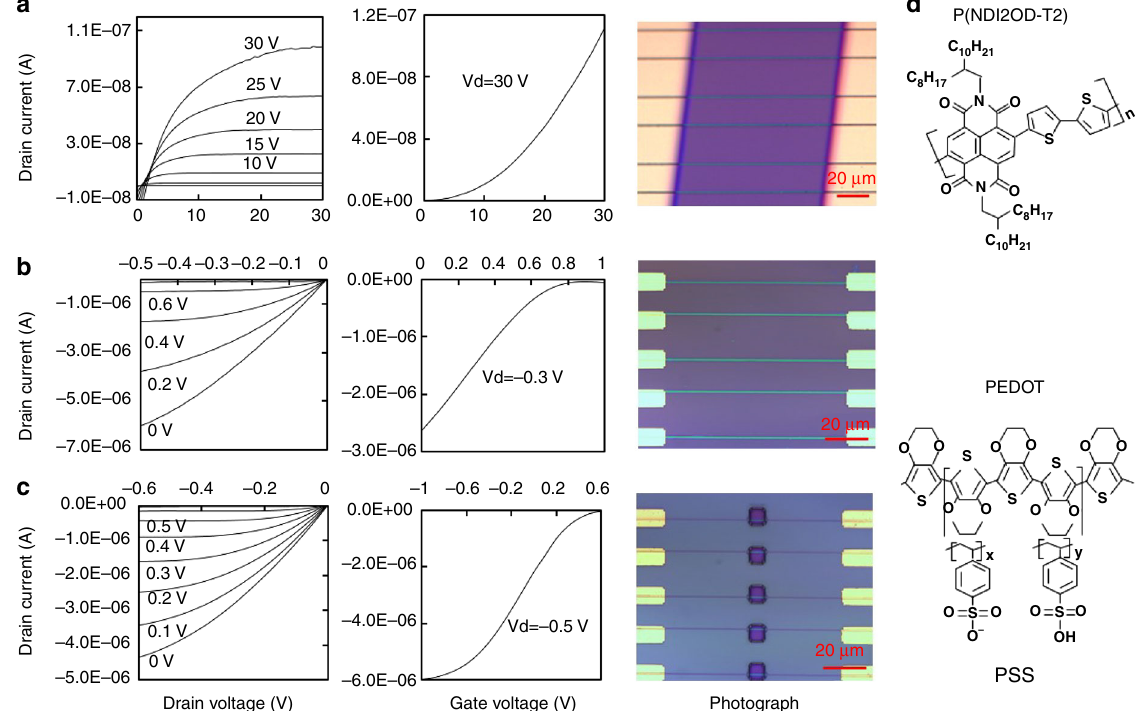
Fig. 3 Performances and images of devices, and molecule structures. a Top-gated FET with n-type P(NDI2OD-T2) wires. b Array of electrochemical transistors with PEDOT:PSS wires. c Electrochemical transistors with PEDOT:PSS wires covered by patterned photoresist for local sensing. d Molecule structures of P(NDI2OD-T2) and PEDOT:PSS